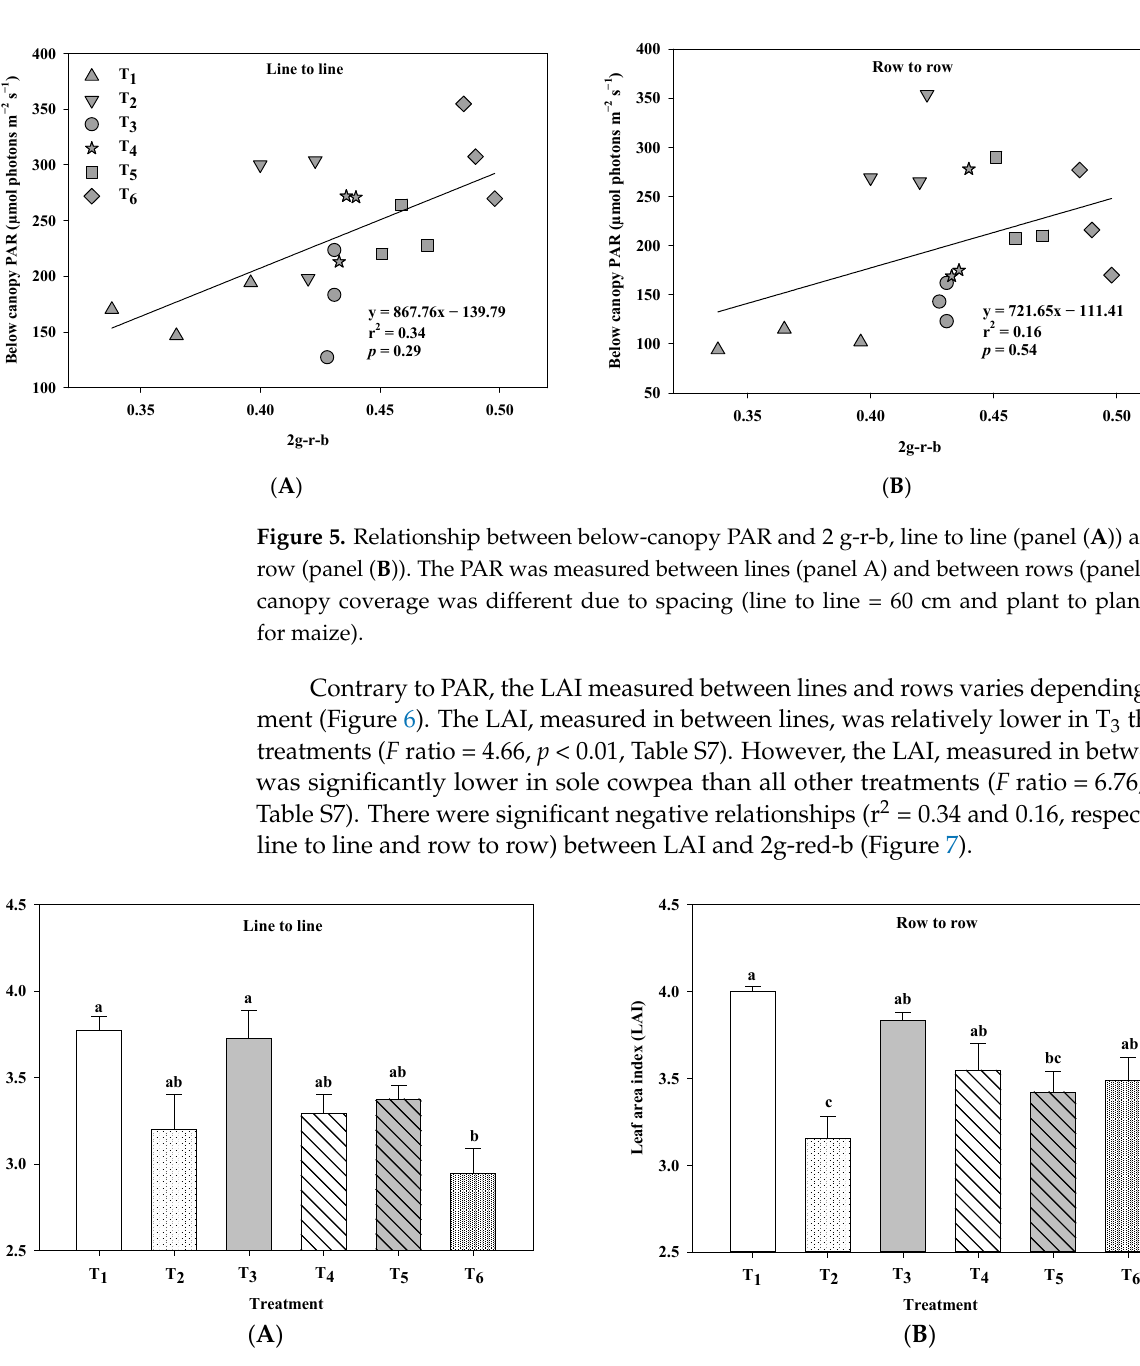
Figure 6. Leaf area index (LAI) of different sole and intercropping treatments. For treatment abbreviations, see Figure 1. The PAR was measured between lines (panel ( A )) and between rows (panel ( B )) since canopy coverage was different due to spacing (line to line = 60 cm and plant to plant = 20 cm for maize) of the crops. Different letters above the bars indicate statistically significant differences at Tukey’s HSD (a = 5%). The error bars represent the standard error of means, N = 3.